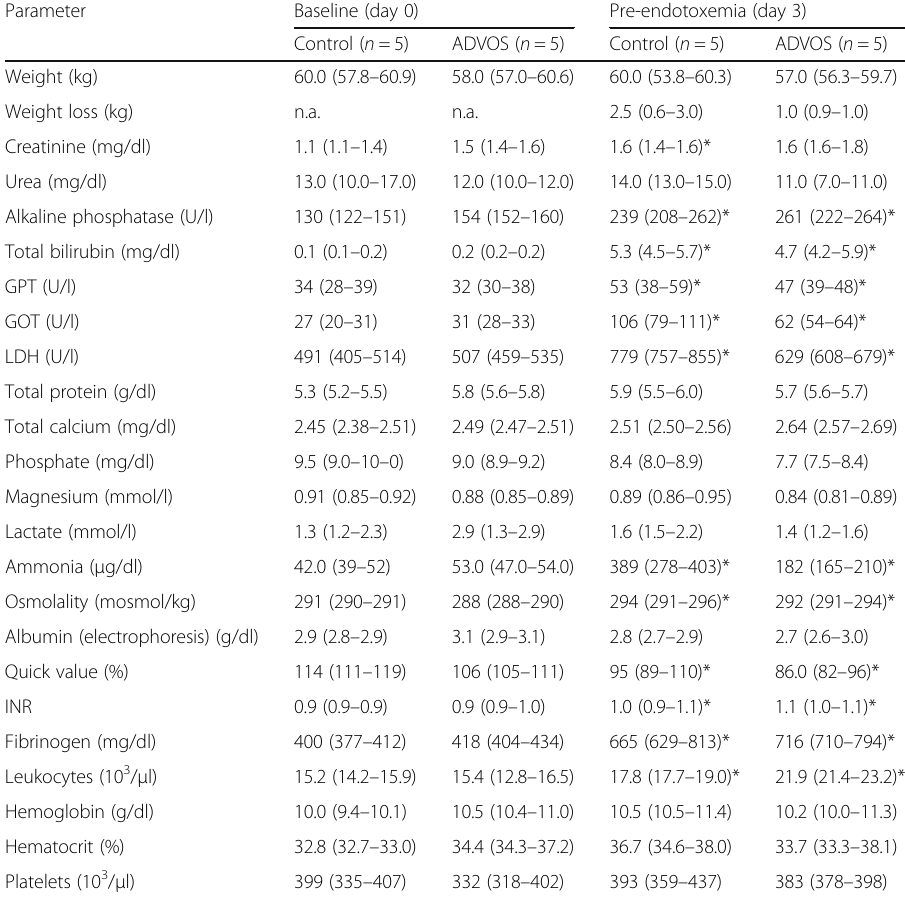
Table 1 Laboratory parameters on day 0 (baseline — before operation) and on day 3 before